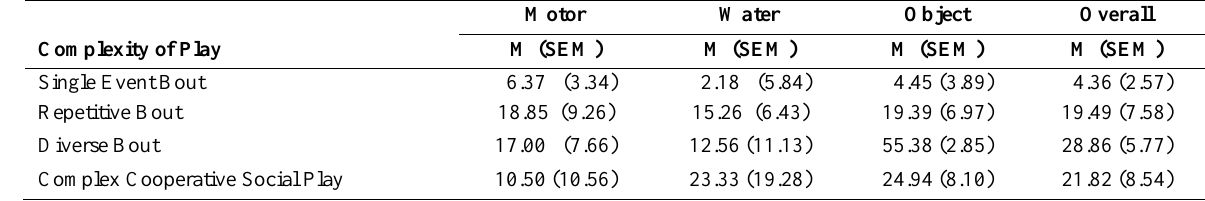
Descriptive Statistics for Duration (sec) of Categories of Type of Play and Complexity of Play Motor